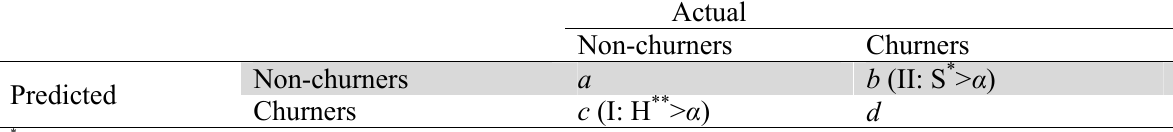
The hypotheses of the survey for testing the proposed hybrid method